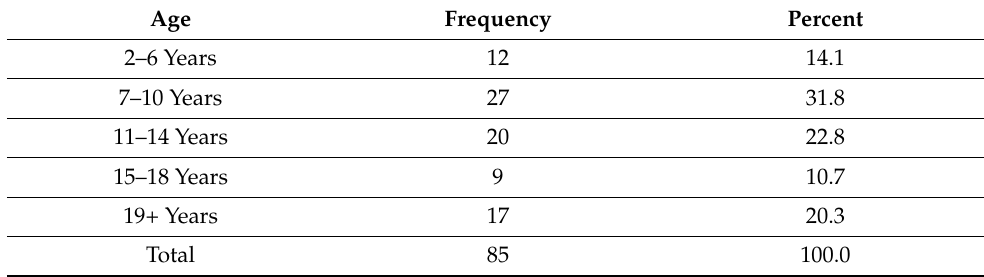
Table 3. Age distribution of individuals with ASD who received APA.